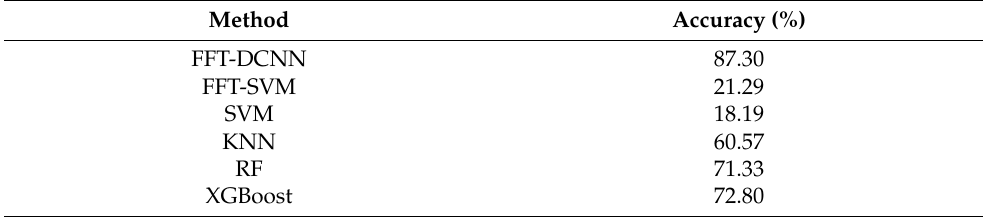
Table 9. Comparison result between the proposed method and ML